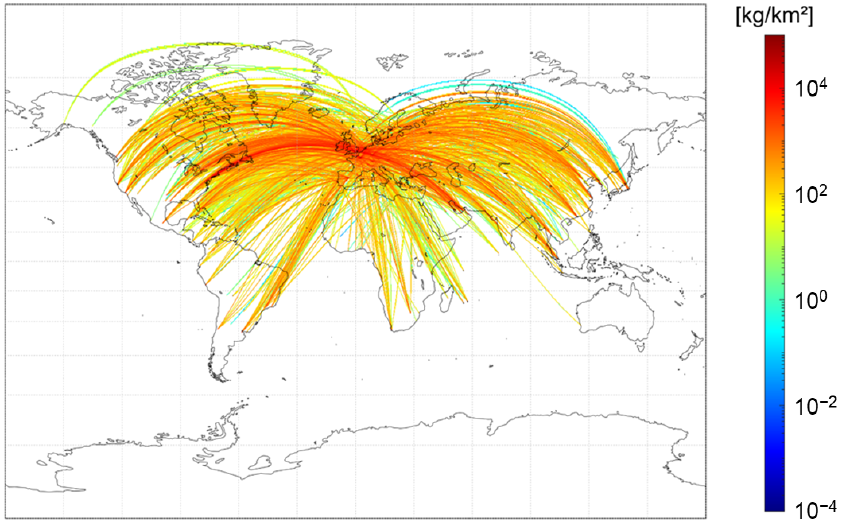
Figure 3. Global distribution of fuel consumption in the reference case, vertically aggregated and normalised per grid cell area given in kg/km 2